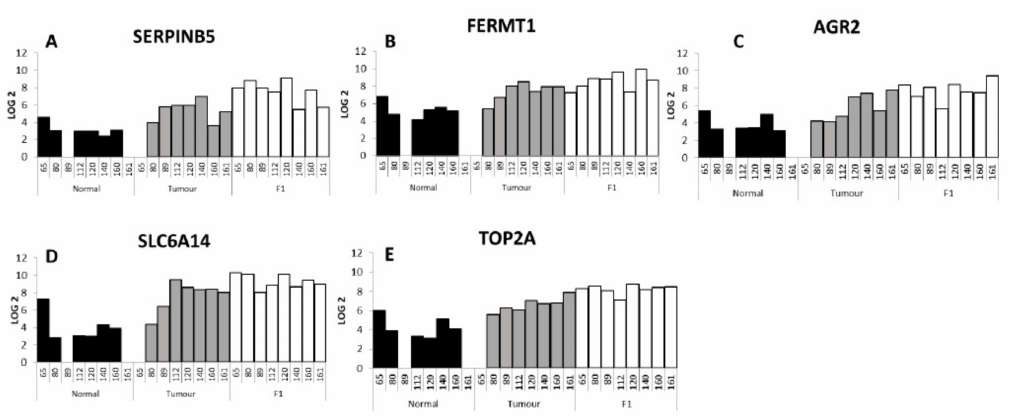
Figure 5. Individual expression of five selected genes, SERPINB5 ( A ) FERMT1 ( B ) AGR2 ( C ) SLC6A14 ( D ) TOP2A ( E ), across the adjacent normal, patient tumour and PDX F1 samples. PIN 089 and PIN 161 adjacent normal samples were not included in the microarray analysis, and PIN 065 patient tumour